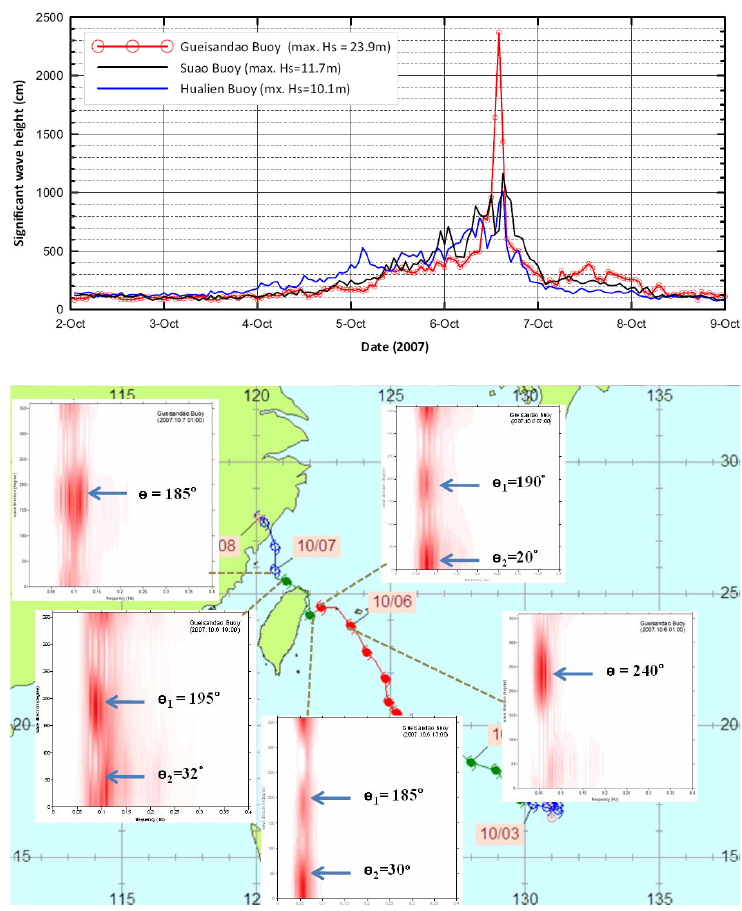
Fig. 3. Top: significant wave height recorded on hourly basis between 2 and 9 October at the Guishandao, Suao and Hualien Buoys. Bottom: Fig. 3. (top): Significant wave height recorded on hourly basis between the 2nd and the 9th of directional wave spectra during Typhoon October at the Guishandao, Suao and Hualien Buoys. (bottom) Directional wave spectra during Typhoon Krosa.